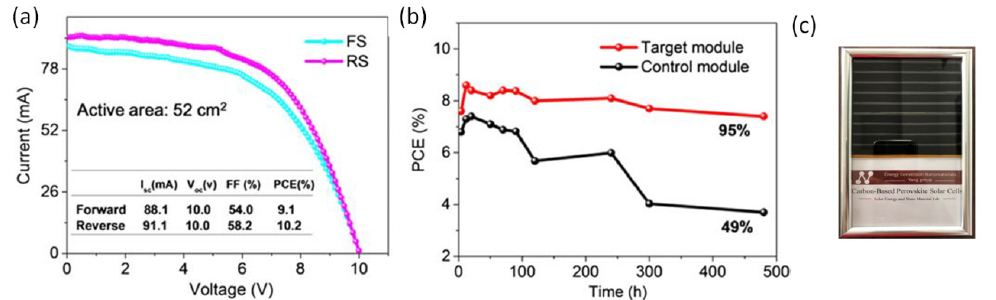
Figure 31. ( a ) The corresponding I–V curves of the champion PSM with forward and backward scanning under simulated standard AM1.5G sunlight. ( b ) PCE degradation curves with storage time under ambient conditions and 40% RH for different PSMs. ( c ) Photograph of a 10 cm × 10 cm PSM [107]. (Reproduced from Ref. [107], 10.1002/ente.201900972, with permission.)